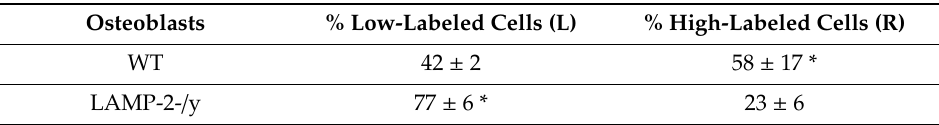
Table 2. Mean labeling intensity of RANKL in WT and LAMP-2- / y osteoblasts. Significantly more high-labeled cells were present in WT fraction whereas the LAMP-2- / y cell fraction contained more low-labeled cells ( n = 8 ± SD, * p <